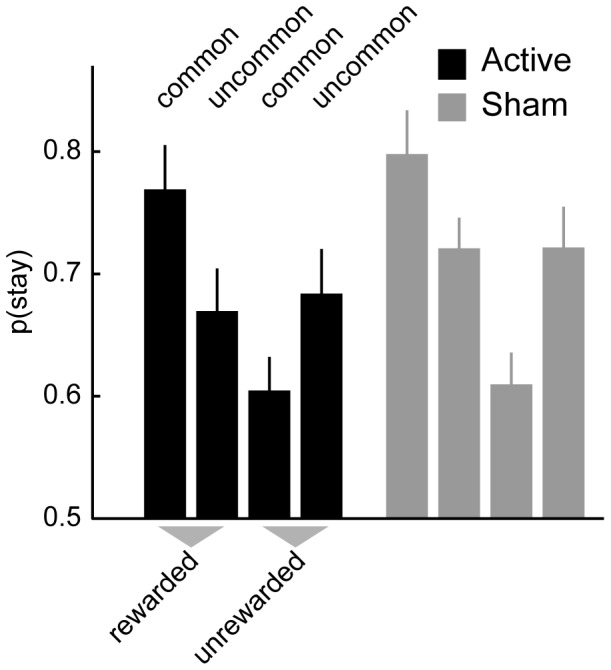
Stay probabilities as a function of reward and transition on previous trial.Participants showed a pattern of stay probabilities characteristic of hybrid model-based/model-free control (cf. Figure 1B) during both Sham and Active stimulation of dlPFC. Error bars indicate SEM.